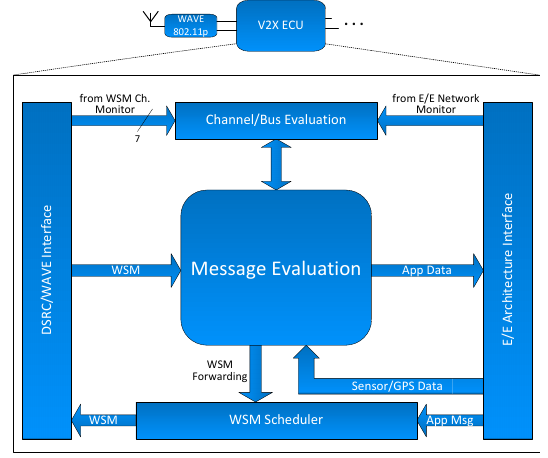
Figure 2: V2X Message Evaluation System